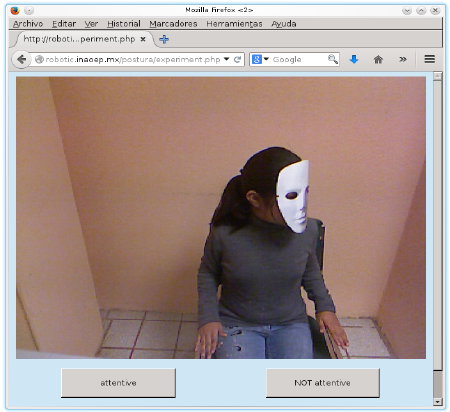
Fig. 1. Screenshot of crowd-evaluation website. (sub1Tor-0-Sho-0-Rar-0-Lar- 0-HeH-30-HeV-0)